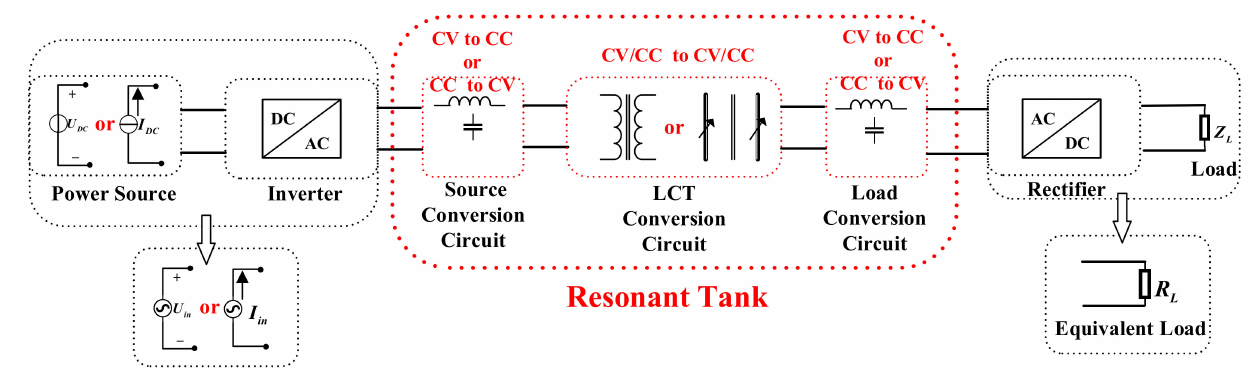
Figure 3. Design diagram for compensation circuit with load-independent constant-voltage (CV) or constant-current (CC) output in IPT